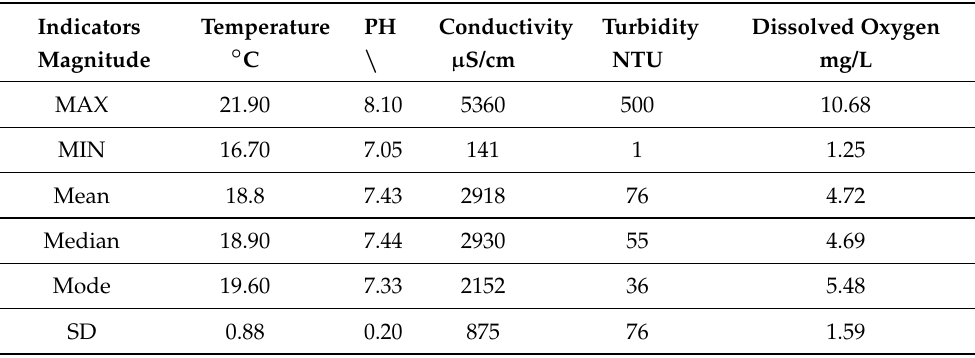
Figure 7. Example time series of dataset. Table 1. Several characteristics of water quality